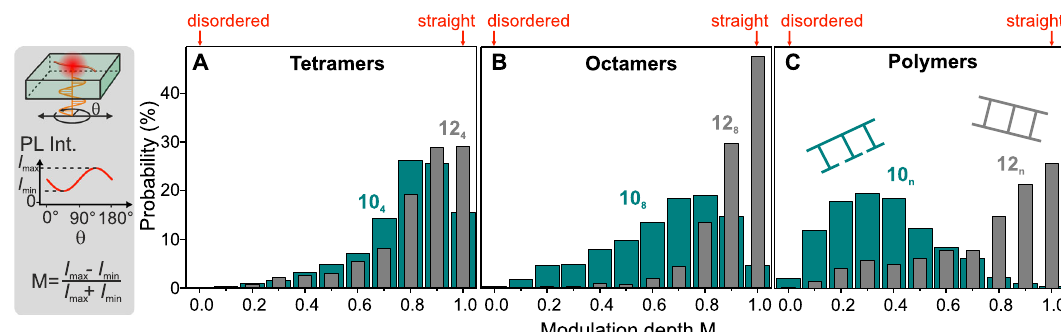
Fig. 3 Molecular rigidity on the single-molecule level. Single molecules are embedded in an inert matrix and imaged with a fl uorescence microscope, recording the intensity as the plane of polarization of the exciting laser is rotated. The fl uorescence modulation depth M offers a metric to assess the rigidity of the chain. The histograms of M are shown for approximately 1000 single molecules each of the open and closed tetramers ( A ), octamers ( B ), and polymers (